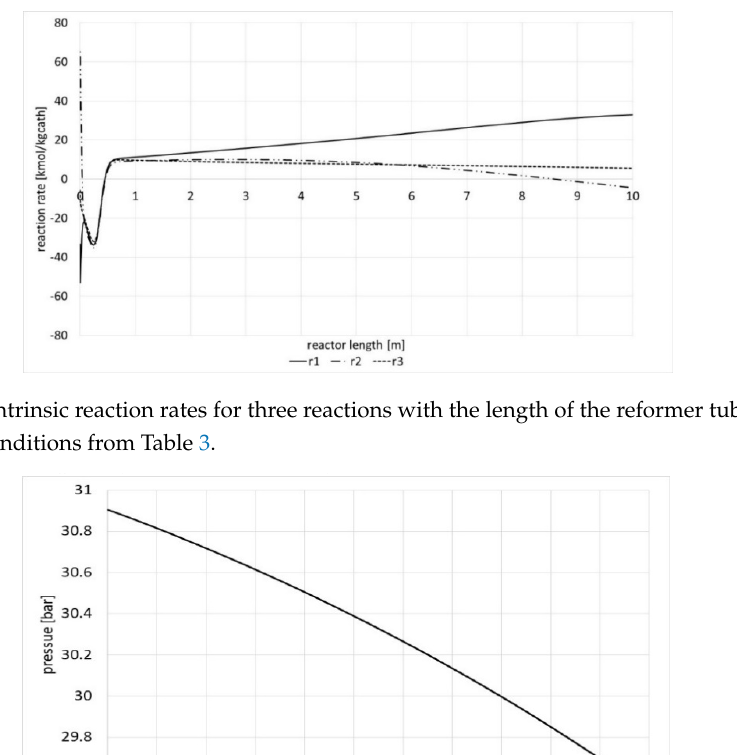
Figure 9. The intrinsic reaction rates for three reactions with the length of the reformer tubes at given inlet process conditions from Table 3.